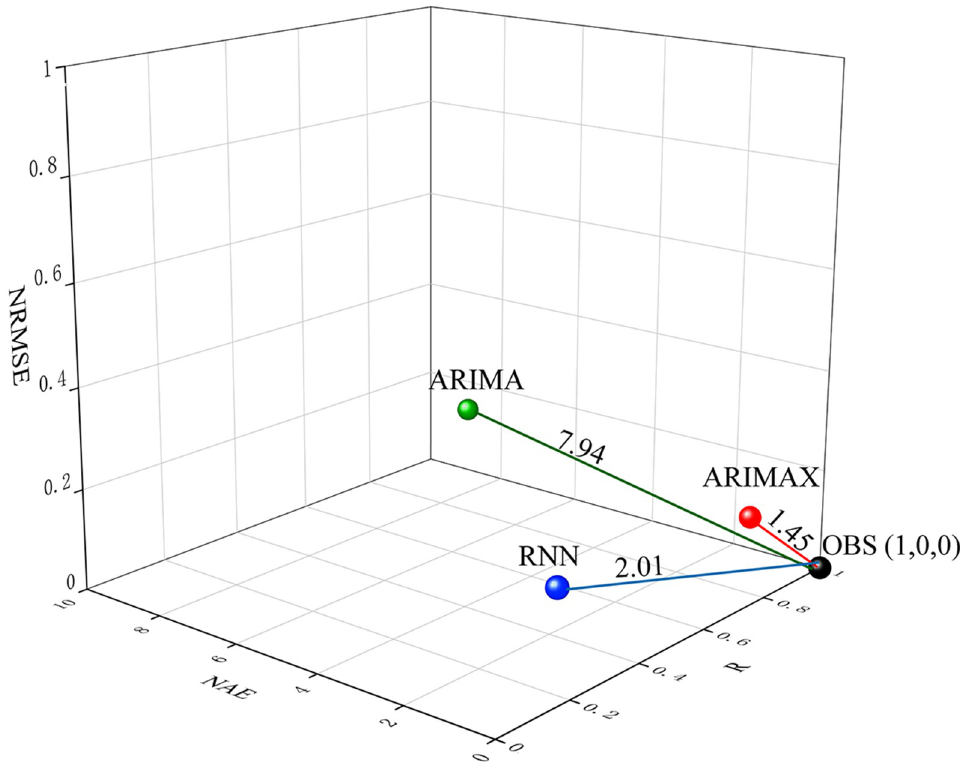
Fig 7. Distances between OBS and simulation results by ARIMA, ARIMAX, and RNN models.